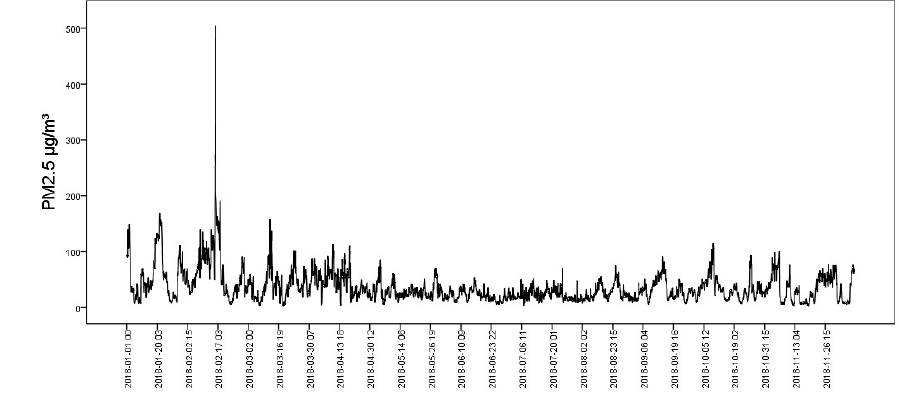
Fig.3 Variation of PM